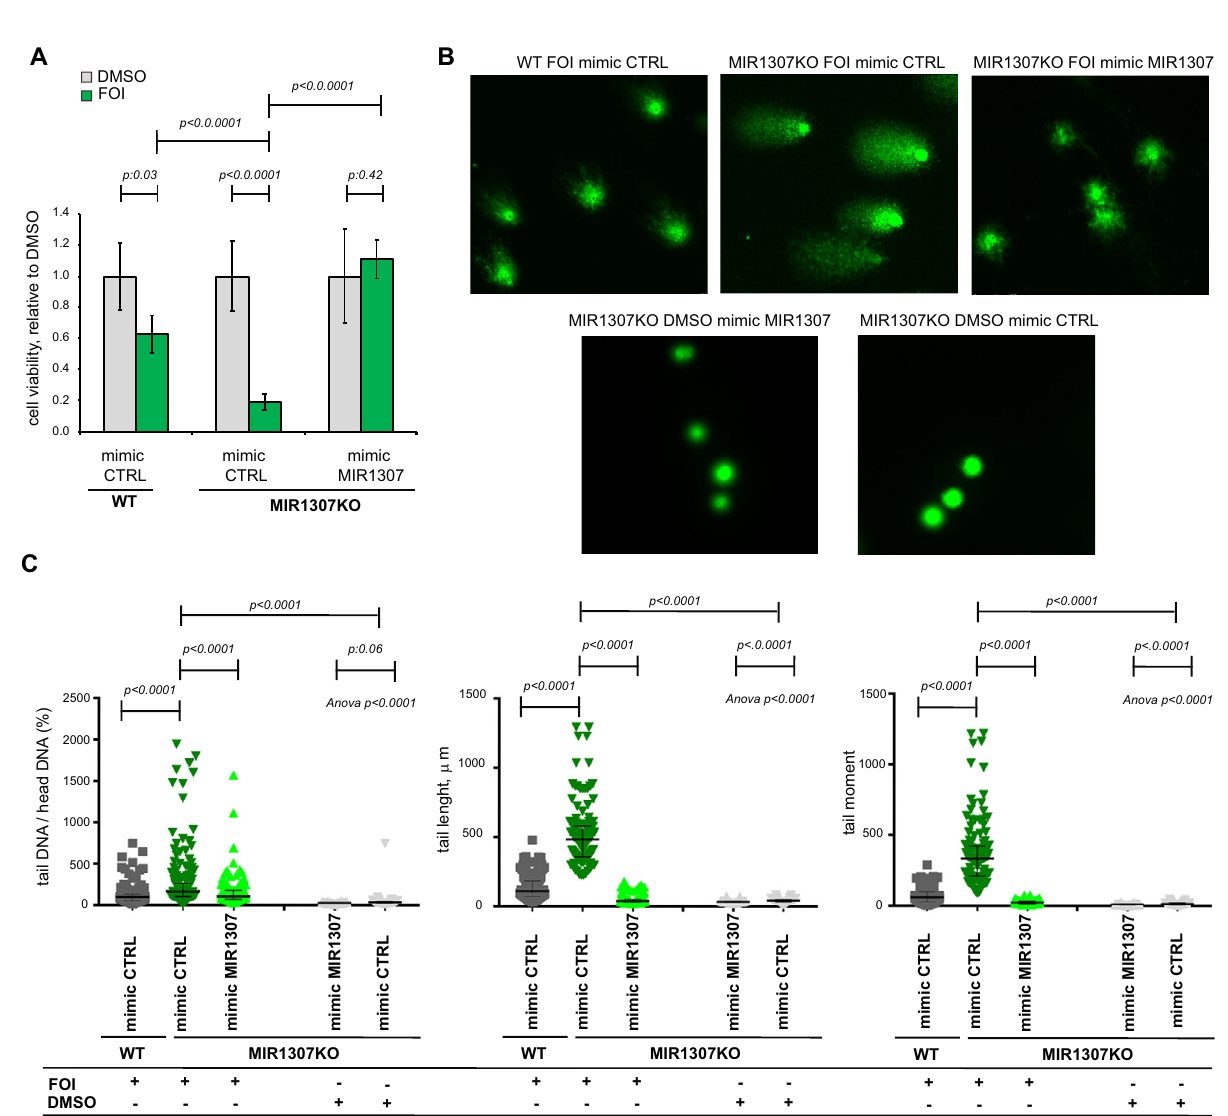
Fig. 4 Re-expression of MIR1307 rescues chemotherapy-induced cytotoxicity and DNA damage in MIR1307KO cells. A Cells were treated with DMSO or FOI chemotherapy for 48 h and assessed for cell viability by CellTiter-Blue. Bars represent the mean and SD of six replicates. Values from two-sided t- test are reported. B Cells were treated for 48 h and COMET assay performed afterwards. Representative images are shown (magni fi cation/scale 20×; magni fi cation bar indicates 50 μ m). C Quanti fi cation plots of the COMET assay are shown with median and interquartile ranges. A median of 90 cells (across three replicates) was assessed for each sample. Values from two-sided t-test are reported. veri fi ed the potential of MIR1307 to be used as a biomarker of baseline pre-treatment plasma samples (Supplementary Table 5). response to FOLFIRINOX chemotherapy in patients undergoing fi rst Analysis of circulating MIR1307 was performed in these samples by line palliative treatment. Patients with unresectable PDAC treated digital droplet PCR. High expression of circulating MIR1307 was with FOLFIRINOX were retrieved from the SSCCG (Screening Study associated with reduced bene fi t from FOLFIRINOX chemotherapy in of Genetic Changes in Colorectal, Gastrointestinal and Hepatobiliary inoperable PDAC patients (Fig. 8) and was independent from disease Cancers) study, which allowed collection of clinically annotated stage (p:0.81) and performance status (p:0.58). NATURE COMMUNICATIONS| (2021) 12:6738